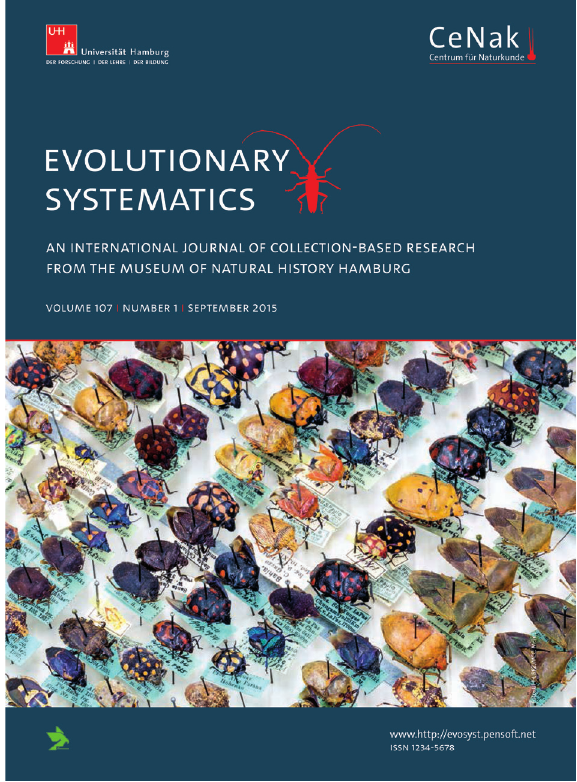
Figure 4. Title page of the “ Mitteilungen aus dem Hamburgi- schen Zoologischen Museum und Institut ”, volume 99 of 2002.